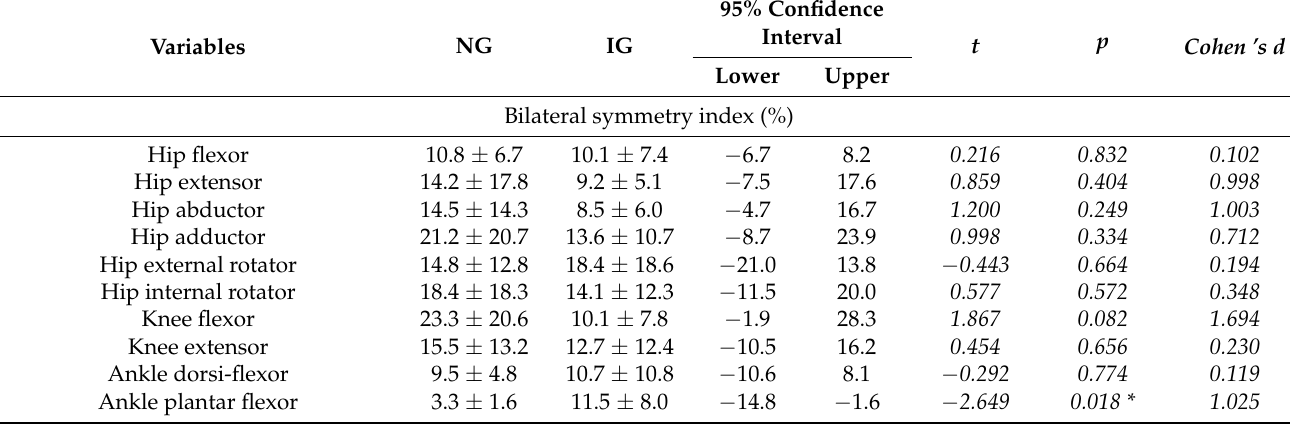
Table 3. Descriptive information for the bilateral/ipsilateral symmetry index of the lower extremities muscular